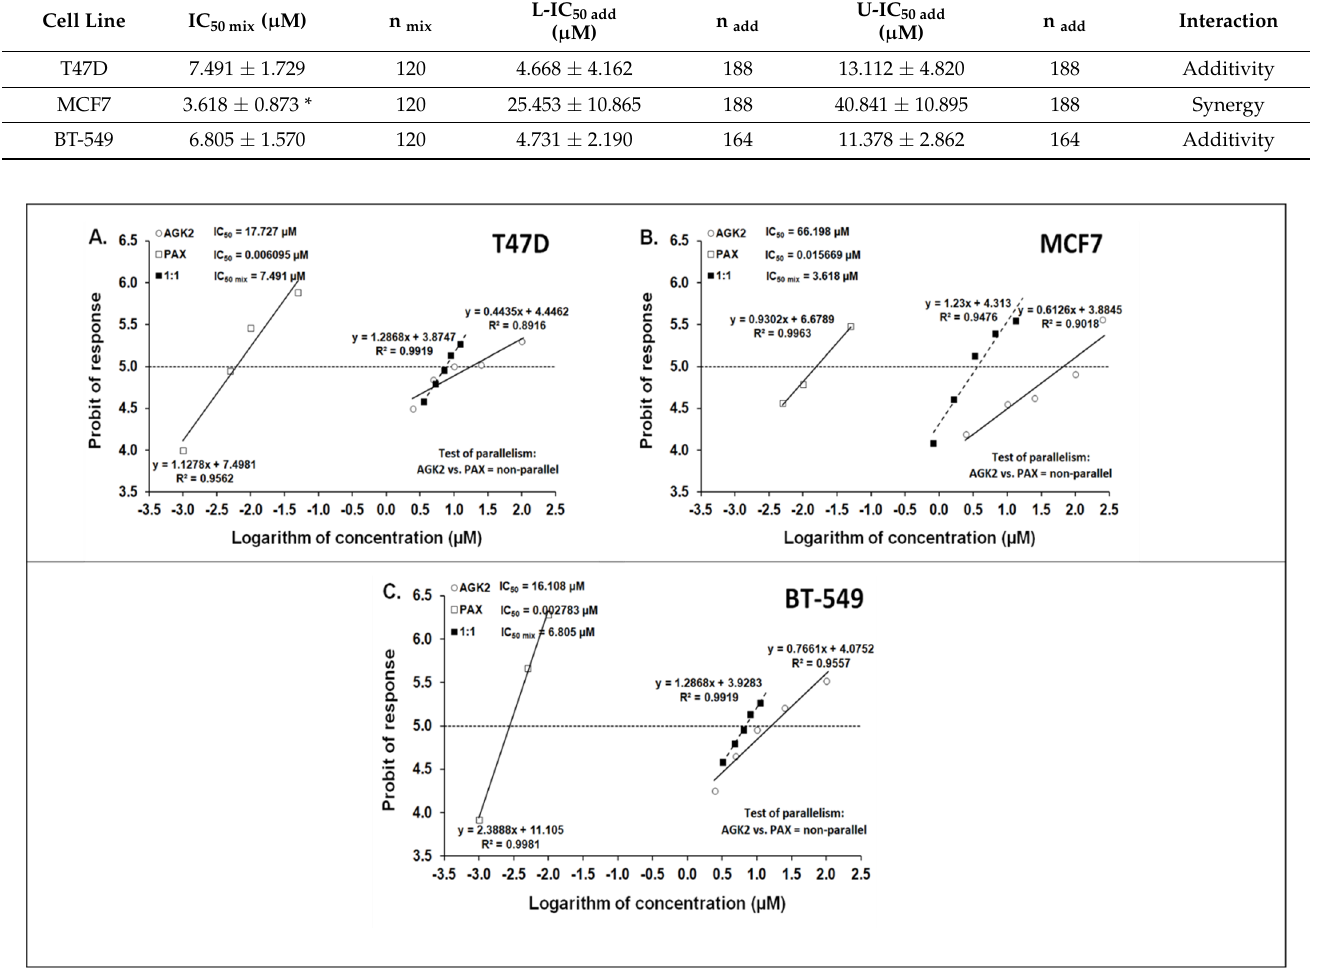
Table 3. Isobolographic analysis for nonparallel concentration–effect curves lines between PAX and AGK2 in the T47D, MCF7 and BT-549 BC cells. The results are presented as the IC 50 values in µ M ± SEM for the two-drug mixtures determined experimentally (IC 50 mix ) and theoretically computed (IC 50 add ) from the equations of additivity, which blocked proliferation in 50% of the tested cells; n mix —total number of items for the experimental mixture; n add —total number of items calculated for the additive mixture of two examined drugs (n add = n_ PAX + n_ AGK2 – 4); L-IC 50 add — lower additive value; U-IC 50 add —upper additive value. Note: * p < 0.05 vs. the respective IC 50 add value (Student’s t -test with Welch’s correction).